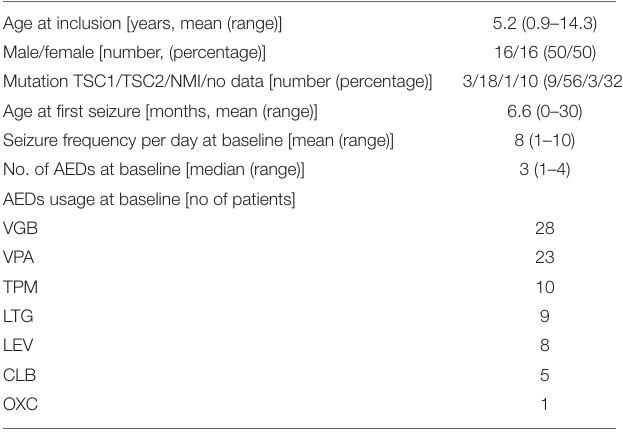
TABLE 1 | Baseline demographics and medical history characteristics. Age at inclusion [years, mean